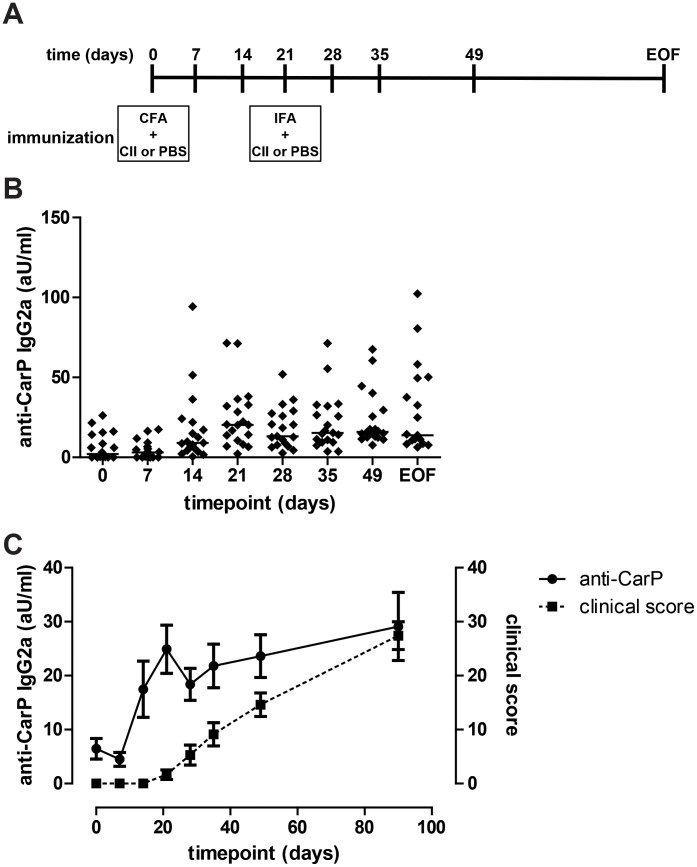
Kinetics of the anti-CarP response during CIA.(A) CIA was induced in DBA/1J mice (n = 19). The mice were immunized at day 0 and boosted at day 21. Blood was harvested from the mice at the indicated time points and serum was stored at −80. The anti-CarP antibody levels were determined in all serum samples simultaneously by ELISA at the end of the experiment. The data shown are the pooled data from 2 independent experiments that showed a similar trend. (B) Anti-CarP IgG2a levels were determined by ELISA. Arbitrary units were calculated using a standard curve of pooled serum from mice with CIA. Every symbol represents one individual mouse and the line indicates the median. (C) Anti-CarP IgG2a antibody levels are plotted on the left Y axes and indicated by the dots with the solid line. The clinical score is plotted on the right Y-axis and indicated by the squares and the dashed line. The error bars indicate the SEM.